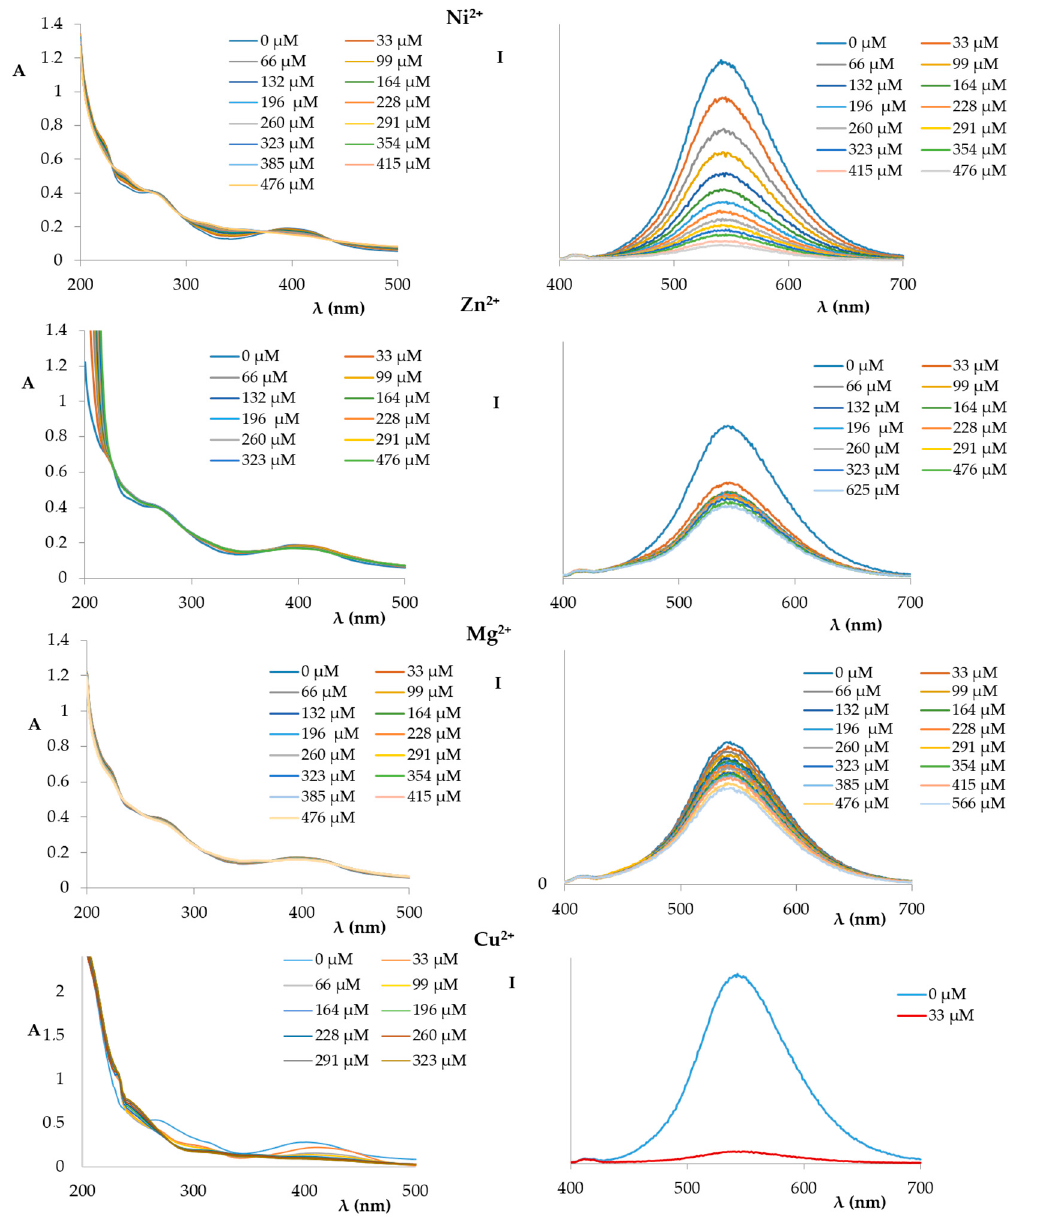
Figure 5. UV spectra ( left ) and fluorescence spectra ( right ) (excitation at 366 nm) of compound 1 (1.72 × 10 − 5 M in EtOH:phosphate buffer) titrated with an increasing amount of Ni 2+ , Zn 2+ , Mg 2+ , and Cu 2+ (1.0 × 10 − 2 M in phosphate buffer).